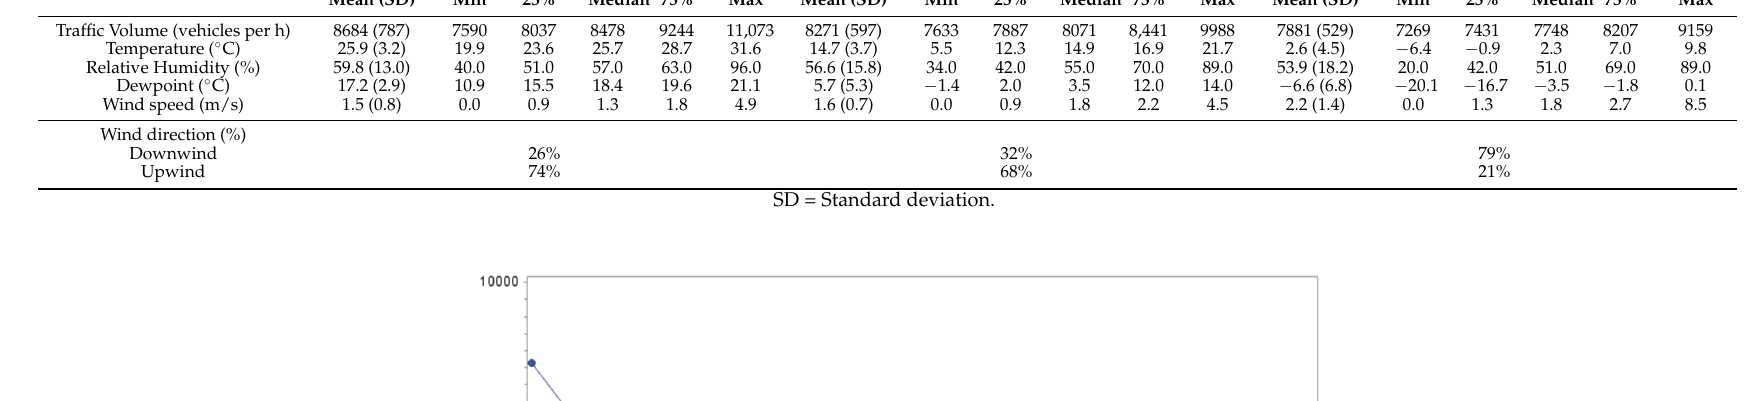
Table 2. Summary statistics of meteorology and traffic during the monitoring periods.